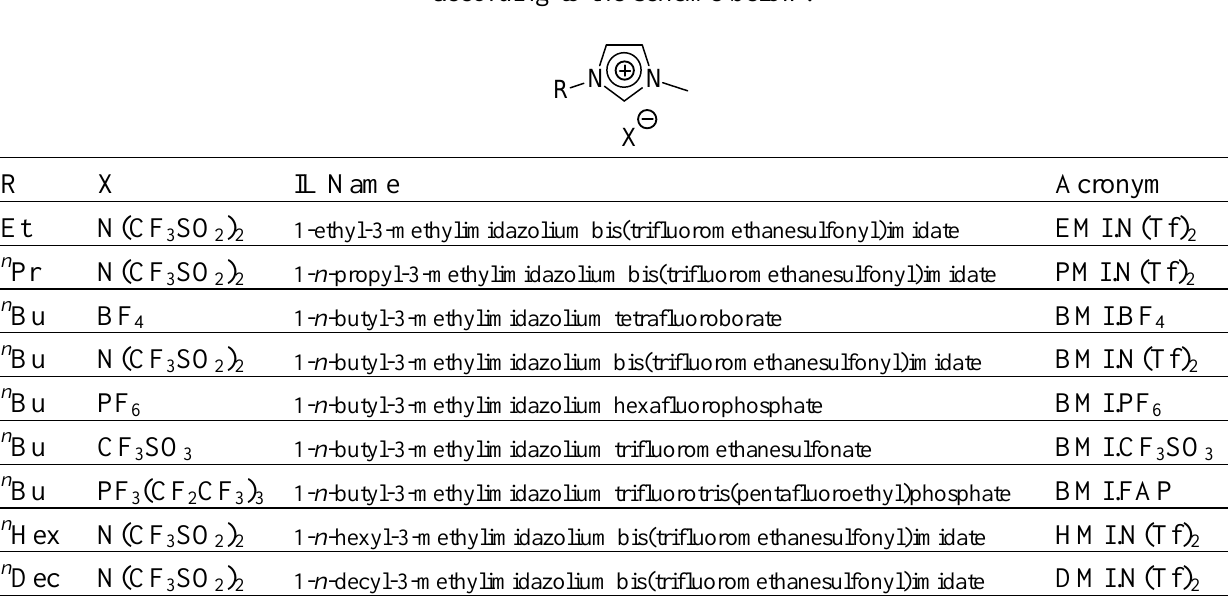
Table 1. Structure, names and acronyms of the ILs reported in this work, according to the scheme below.